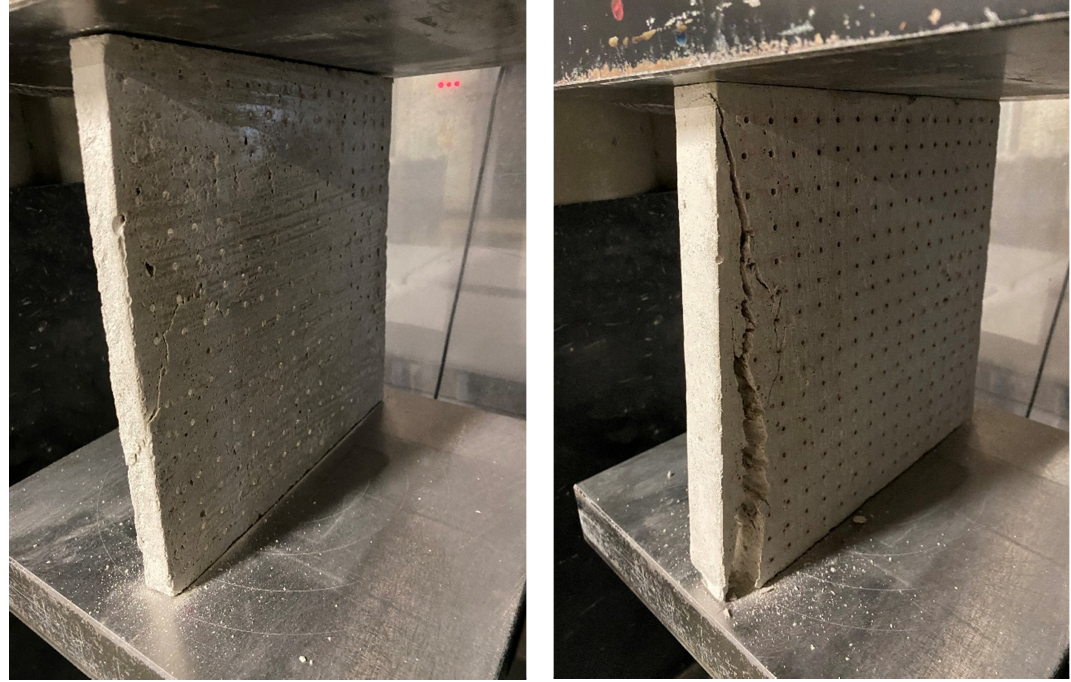
Figure 38. Compressive strength test—slab with POF and GF ( left ) and slab with air holes and GF ( right ).